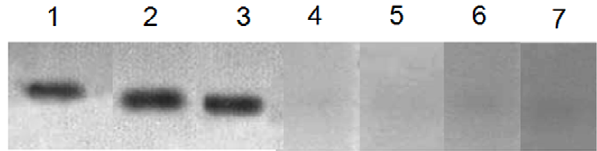
Figure 1. Sensitivity of the described procedure. Different concentrations of BSA were separated by SDS-PAGE and stained with water-soluble CBBR at boiling temperature for 60 s. Lanes 1–6 represent 10 ng, 100 ng, 500 ng, 1 m g, 5 m g, and 10 m g of BSA.